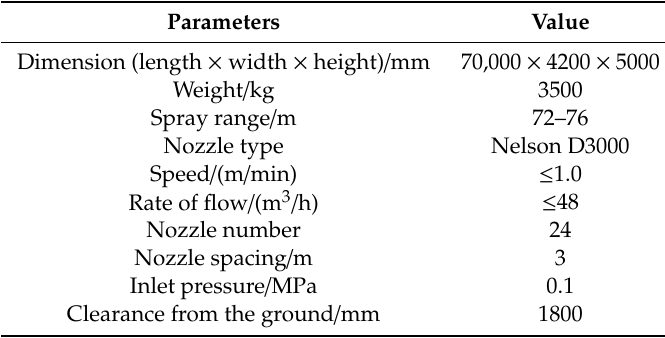
Figure 2. Driving mode of the wheel drive.